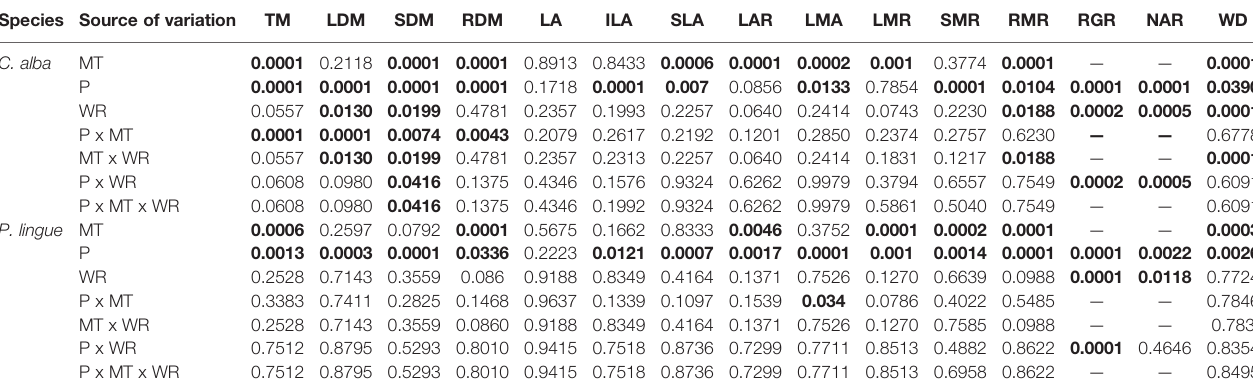
TABLE 3 | Summary of three-way repeated measures ANOVA p-values for treatment effects on total biomass (TM), leaf dry mass (LDM), shoot dry mass (SDM), root dry mass (RDM), leaf area (LA), individual leaf area (ILA), speci fi c leaf area (SLA), leaf area ratio (LAR), leaf mass per area (LMA), leaf mass ratio (LMR), shoot mass ratio (SMR), root mass ratio (RMR), relative growth rate (RGR), net assimilation rate (NAR), and wood density (WD) in Cryptocarya alba and Persea lingue plants. Species Source of